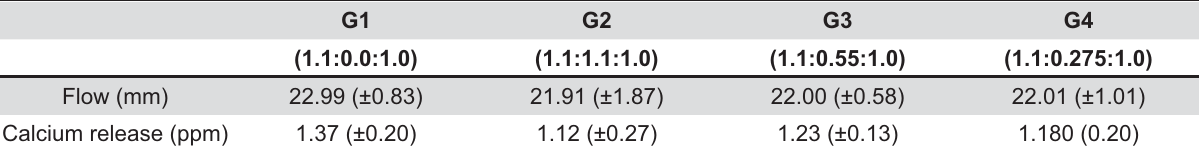
powder:iodoform:resin (in weight) Table 2-